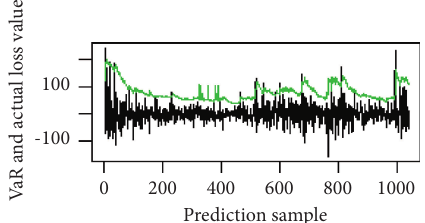
Figure 8: VaR value based on the GARCH GED model.